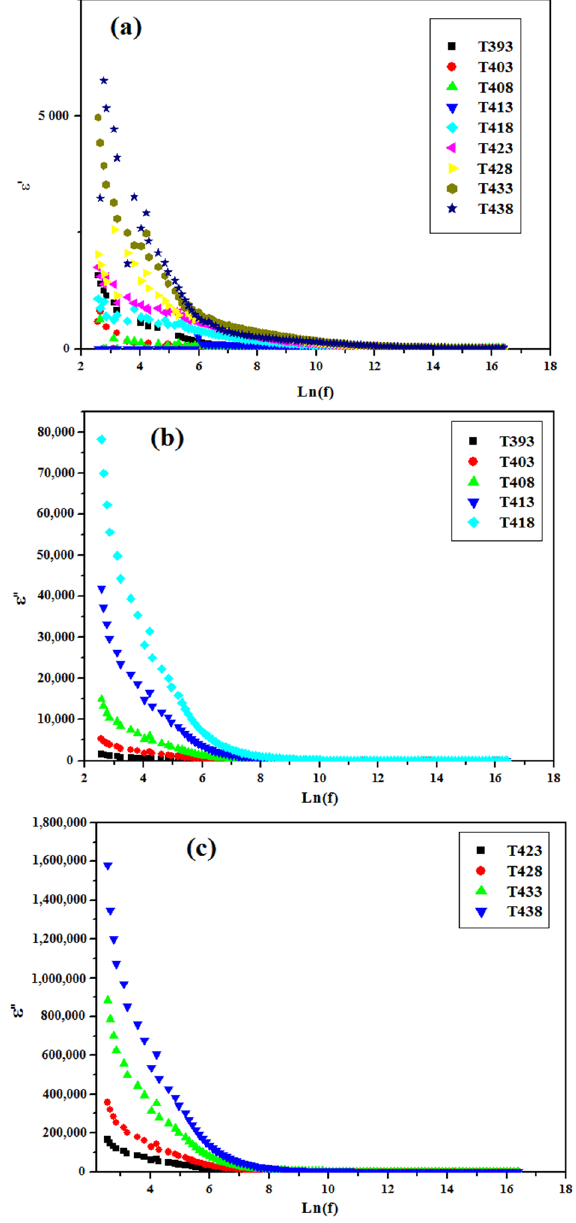
Figure 9. ( a ) ε ’ versus Ln(f) in the temperature range from 393 to 438 K; ( b ) ε ” versus Ln(f) in the temperature range from 393 to 418 K; ( c ) ε ” versus Ln(f) in the temperature range from 423 to 438 K